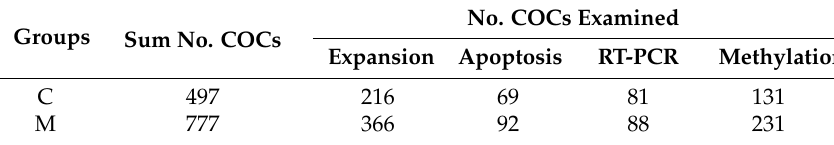
Table A1. Number of COCs used per group for different tests ( n = 9).